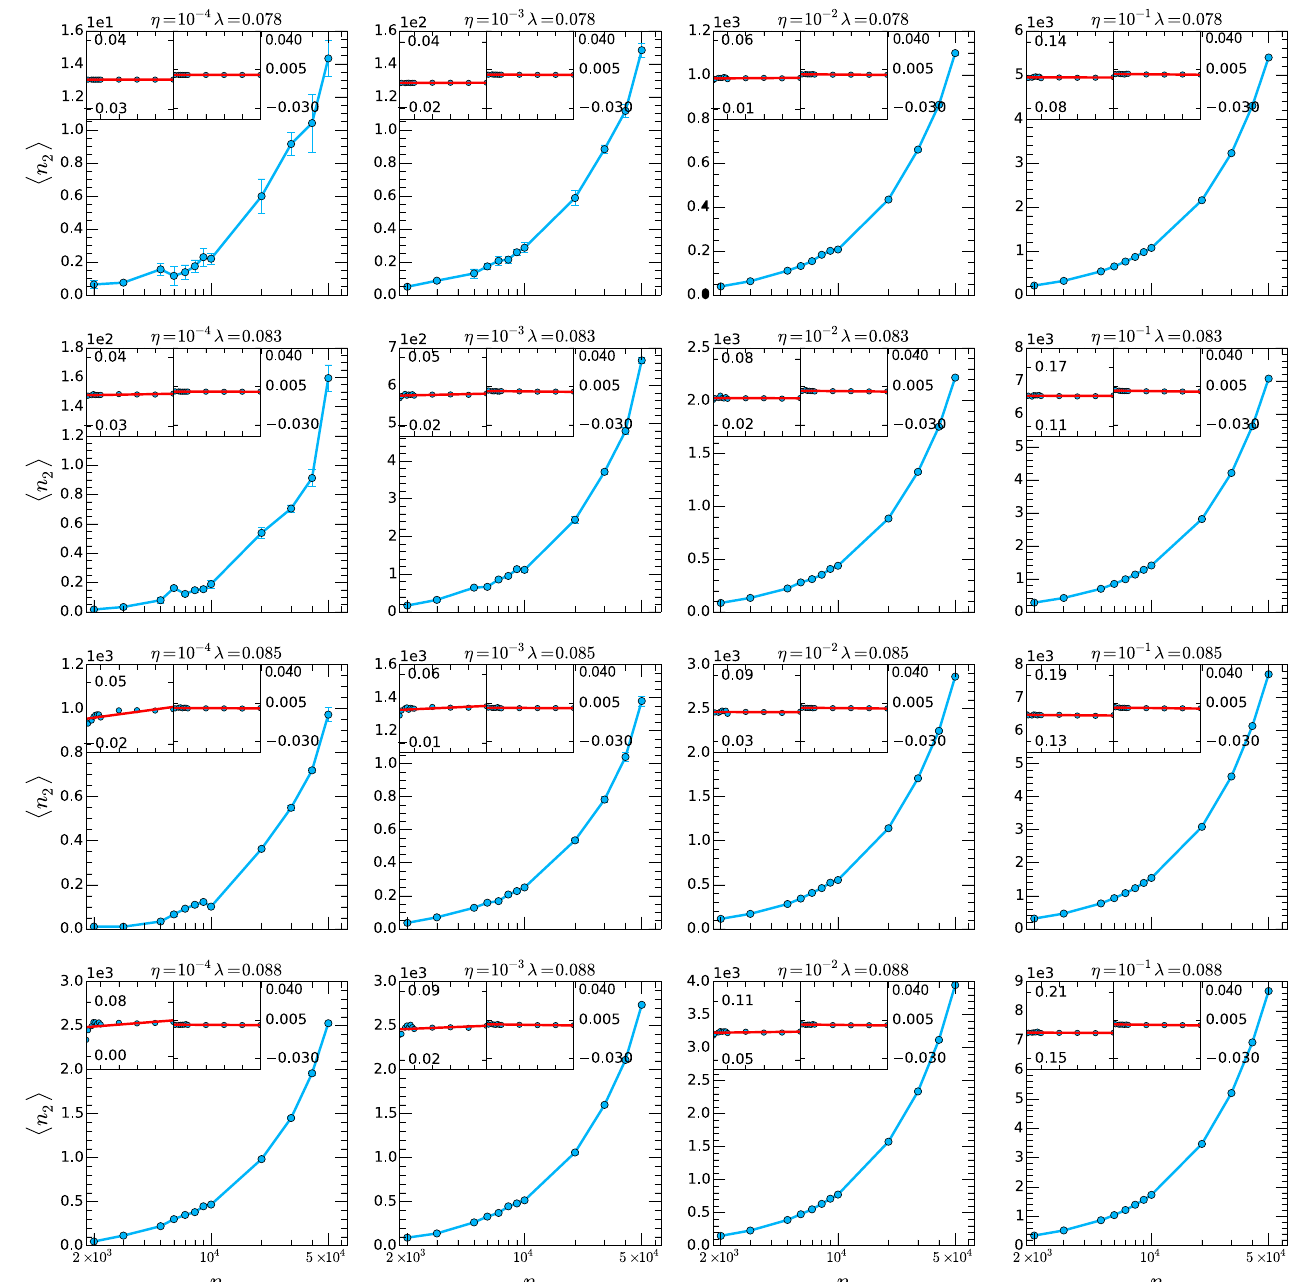
FIG. 12. The final number of infected nodes in the second layer (with lowest individual eigenvalue) as a function of the size of the layers on the main panels. In the insets, we present the fraction of infected nodes (on the left) and the standard deviation in the steady state (on the right). The parameters used in the simulations are shown in the tile of each panel. They are a combination of the parameters λ ¼ 0 . 078 , 0.083, 0.085, 0.088 and η ¼ 10 − 4 , 10 − 3 , 10 − 2 , 10 − 1 . Furthermore, the layer sizes are n ¼ 2 × 10 3 , 3 × 10 3 , 4 × 10 3 , 5 × 10 3